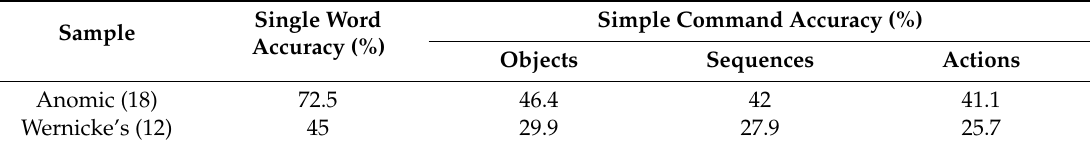
Table 5. Performance analysis summary of comprehension task.